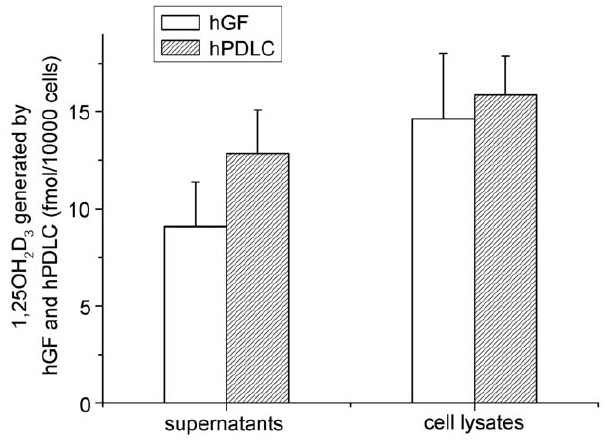
Figure 4. 1,25OH 2 D 3 generation by hGF and hPDLC. hGF and hPDLC from donors 2, 4 and 5 were incubated with 1000 nM vitamin D 3 for 48 h, and the production of 1,25OH 2 D 3 was determined in supernatants and cell lysates. The amount of 1,25OH 2 D 3 generated was not significantly different between hGF and hPDLC. The data are presented as the mean 6